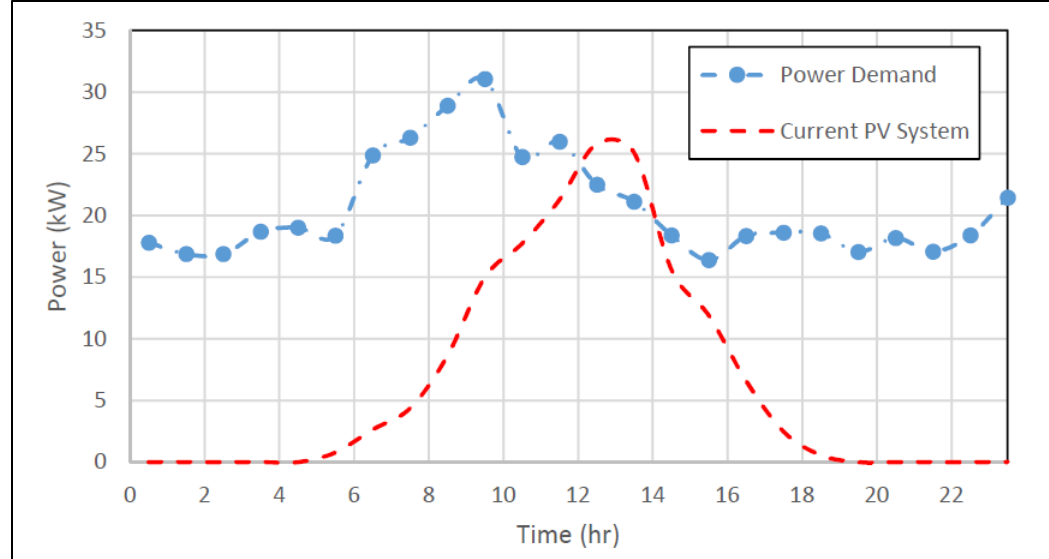
Figure 8. Essential load demand and PV generation during a weekend.